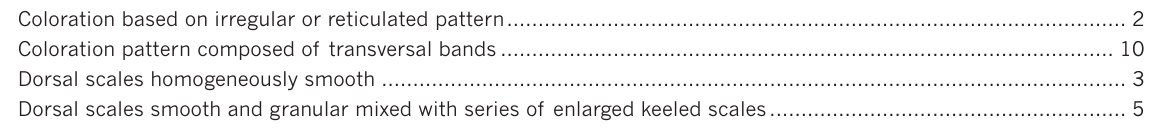
Key for identification of the species of the genus Homonota Information to generate the key was based on Cacciali et al. (2007b), Avila et al. (2012), and Cájade et al. (2013). Given that the holotype of H. fasciata is completely bleeched, we consider the information on its coloration from the original color description (Duméril and Bibron